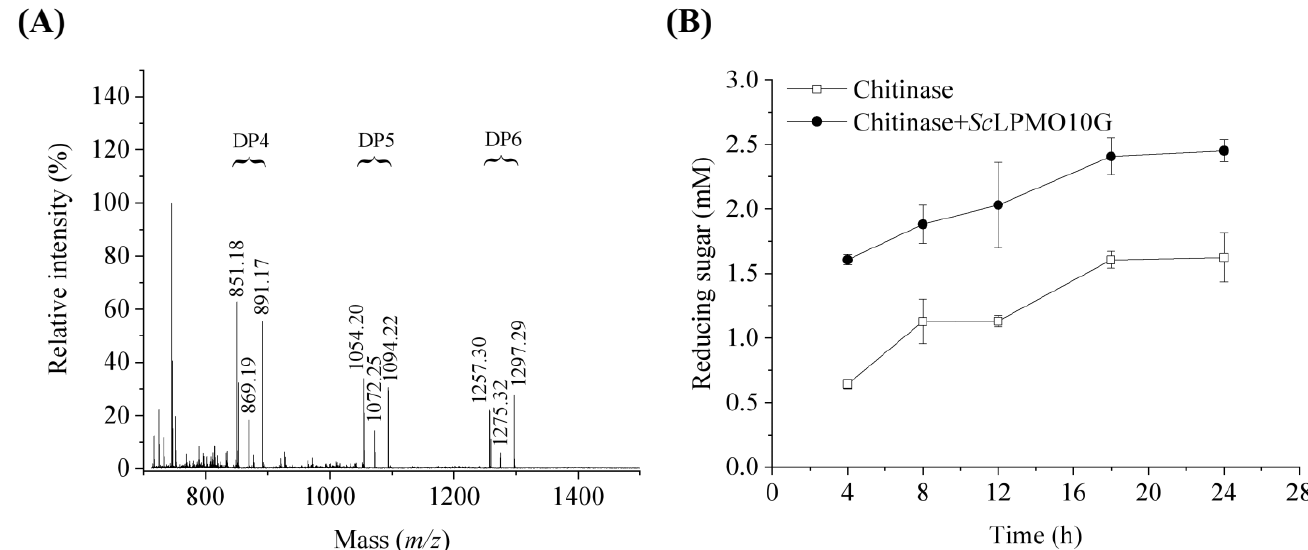
Figure 2. Activity of Sc LPMO10G on chitin. ( A ) Chitin degradation products by Sc LPMO10G activity identified using MALDI TOF MS analysis. DP indicates the degree of polymerisation of oxidized oligosaccharides. Possible products in these clusters are the sodium adducts of the lactone ( m / z 851.18, 1054.20, 1257.30), the sodium adducts of the aldonic acid ( m / z 869.19, 1072.25, 1275.32), and the sodium adduct of the aldonic acid sodium salt ( m / z 891.17, 1094.22, 1297.29). 100% relative intensity represents 1.9 × 10 4 arbitrary units (a.u.) for full spectra. ( B ) Degradation of 10.0 mg/mL chitin by 0.2 μ M chitinases in the presence (solid circle) or absence (hollow square) of 2 μ M Sc LPMO10G, with ascorbic acid (1.0 mM) used as the electron donor. All experiments were performed in triplicate and standard deviation analysis was conducted (SD, n = 3).